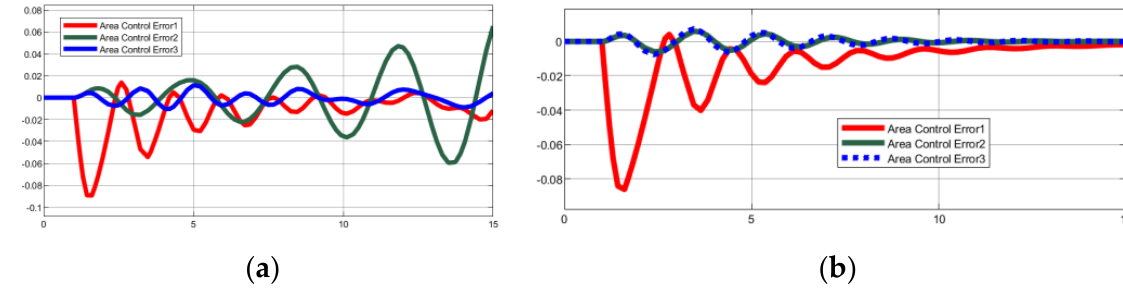
Figure 12. ( a ) ACEs, Case 3. ( b ) ACEs, Case 4.